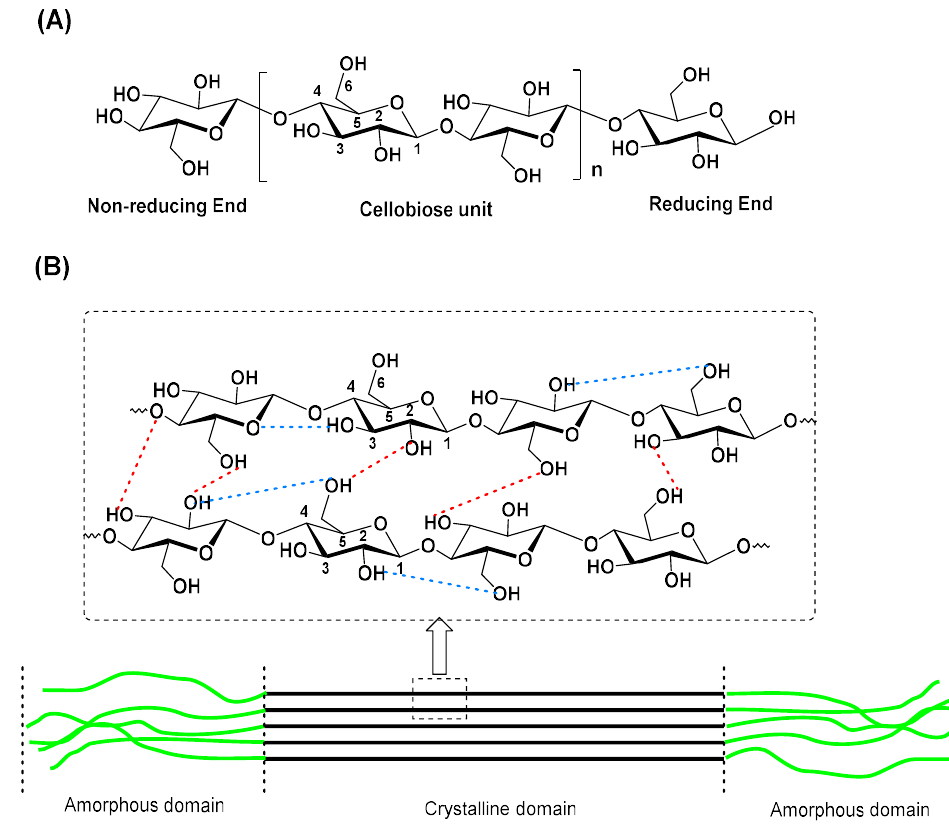
Figure 1. Structure of cellulose: ( A ) Molecular structure of cellulose with cellobiose as a repeating unit and ( B ) inter (red dotted line) and intra molecular hydrogen bonds (blue dotted line) interactions between cellulose chains within the crystalline region of the cellulose microfibrils.